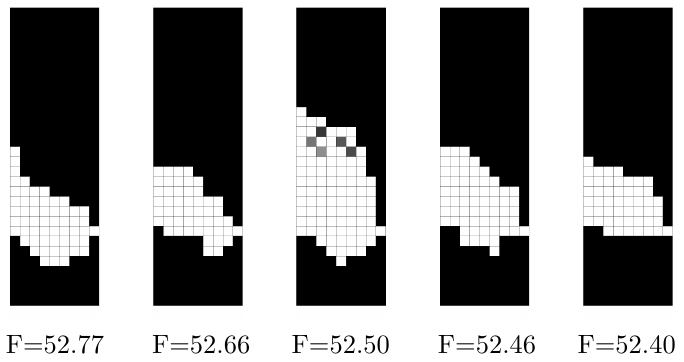
Figure 22. Optimized topologies.